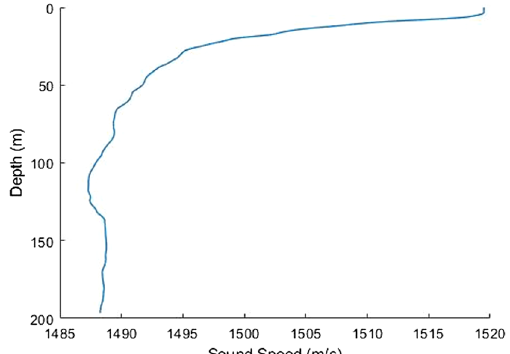
Fig. 7 Simulation of sound velocity profile